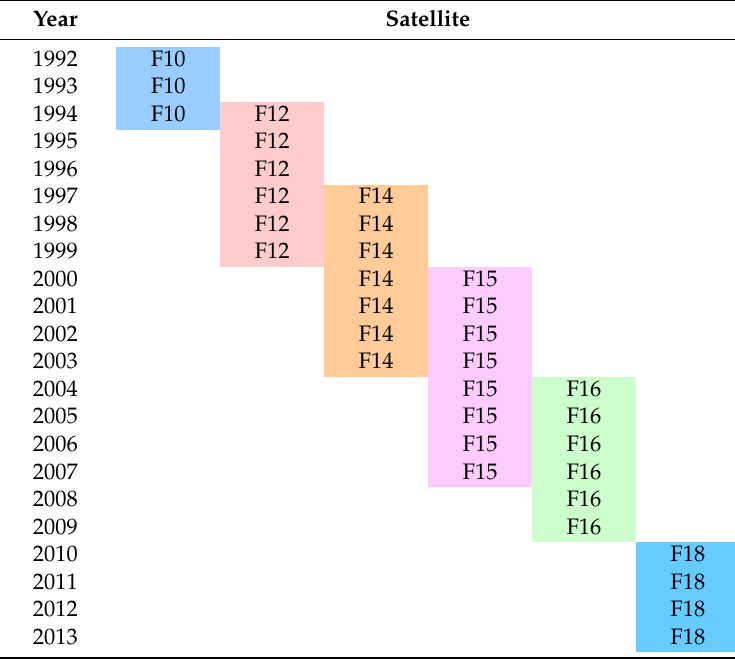
Table 1. Annual composites of the stable Defense Meteorological Satellite Program/Operational Linescan System Nighttime Light (DMSP/OLS NTL)